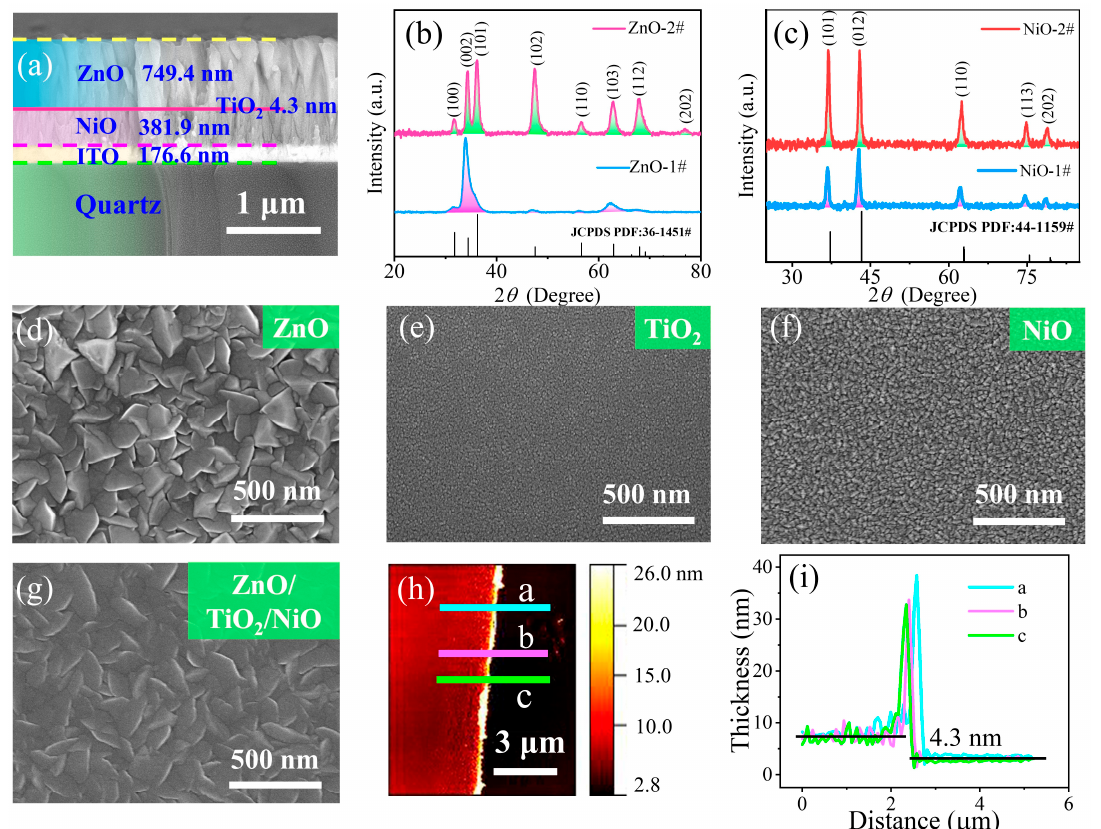
Figure 2. ( a ) Cross-sectional SEM image of ZnO/TiO 2 /NiO films. ( b , c ) XRD patterns of ZnO and NiO films, respectively. ( d – f ) SEM images of ZnO, TiO 2 , and NiO films, respectively. ( g ) Top-view SEM image of ZnO/TiO 2 /NiO films. ( h , i ) AFM image and line profiles for thickness measurement of TiO 2 film,